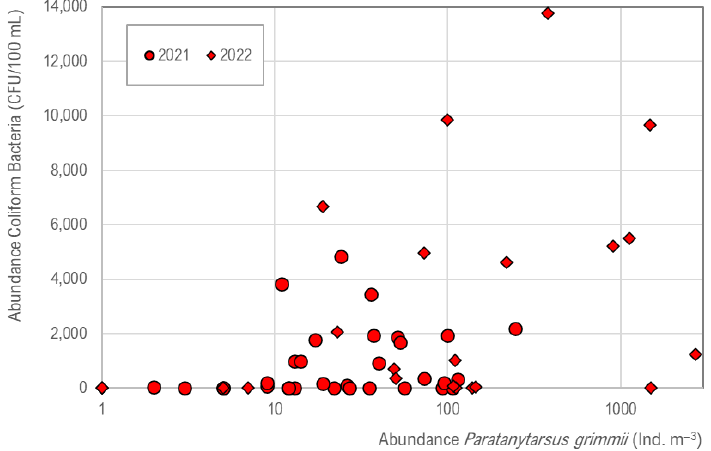
Figure 7. Correlation of Paratanytarsus grimmii abundance (ind. m −3 ) and coliform bacteria (CFU 100 mL −1 ), with a tendency of co-existence. The number of coliform bacteria is determined with pipe flushing of 1 m s −1 and does not correspond to normal conditions of drinking water